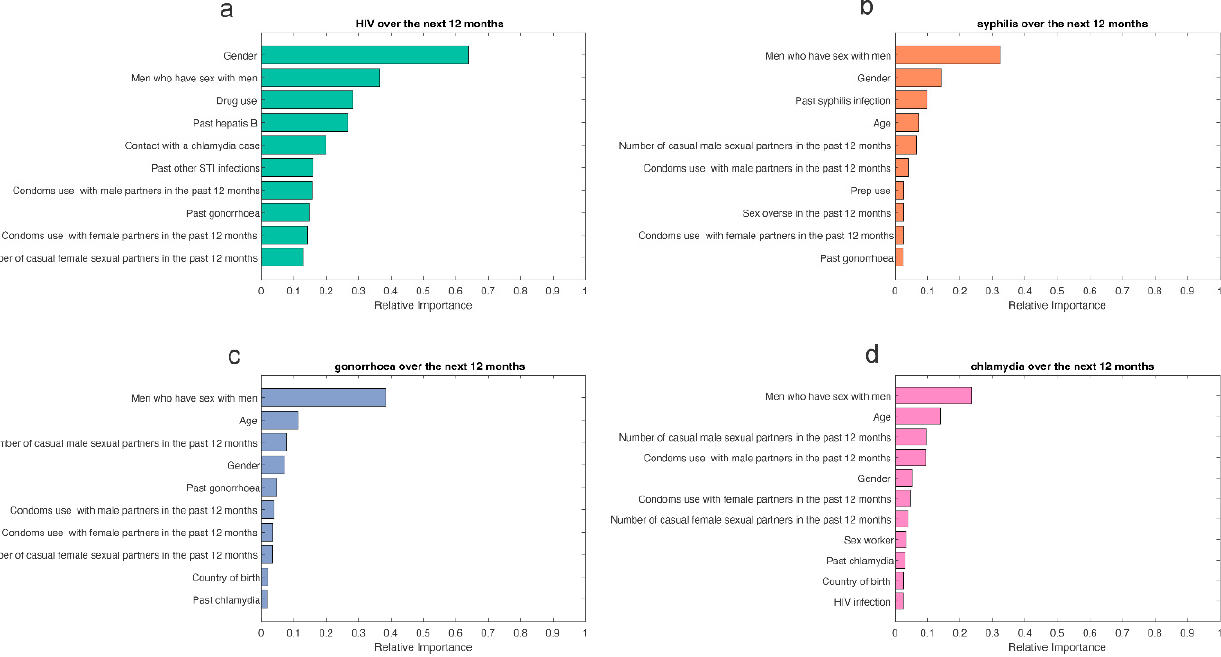
Figure 1. Variable importance analysis for predicting ( a ) HIV, ( b ) syphilis, ( c ) gonorrhoea, and ( d ) chlamydia over the next 12 months.